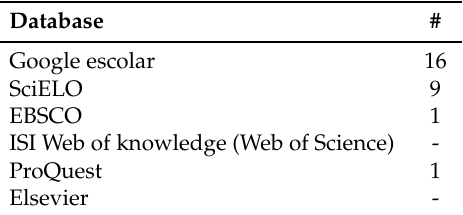
Table 4. Known scientific database.